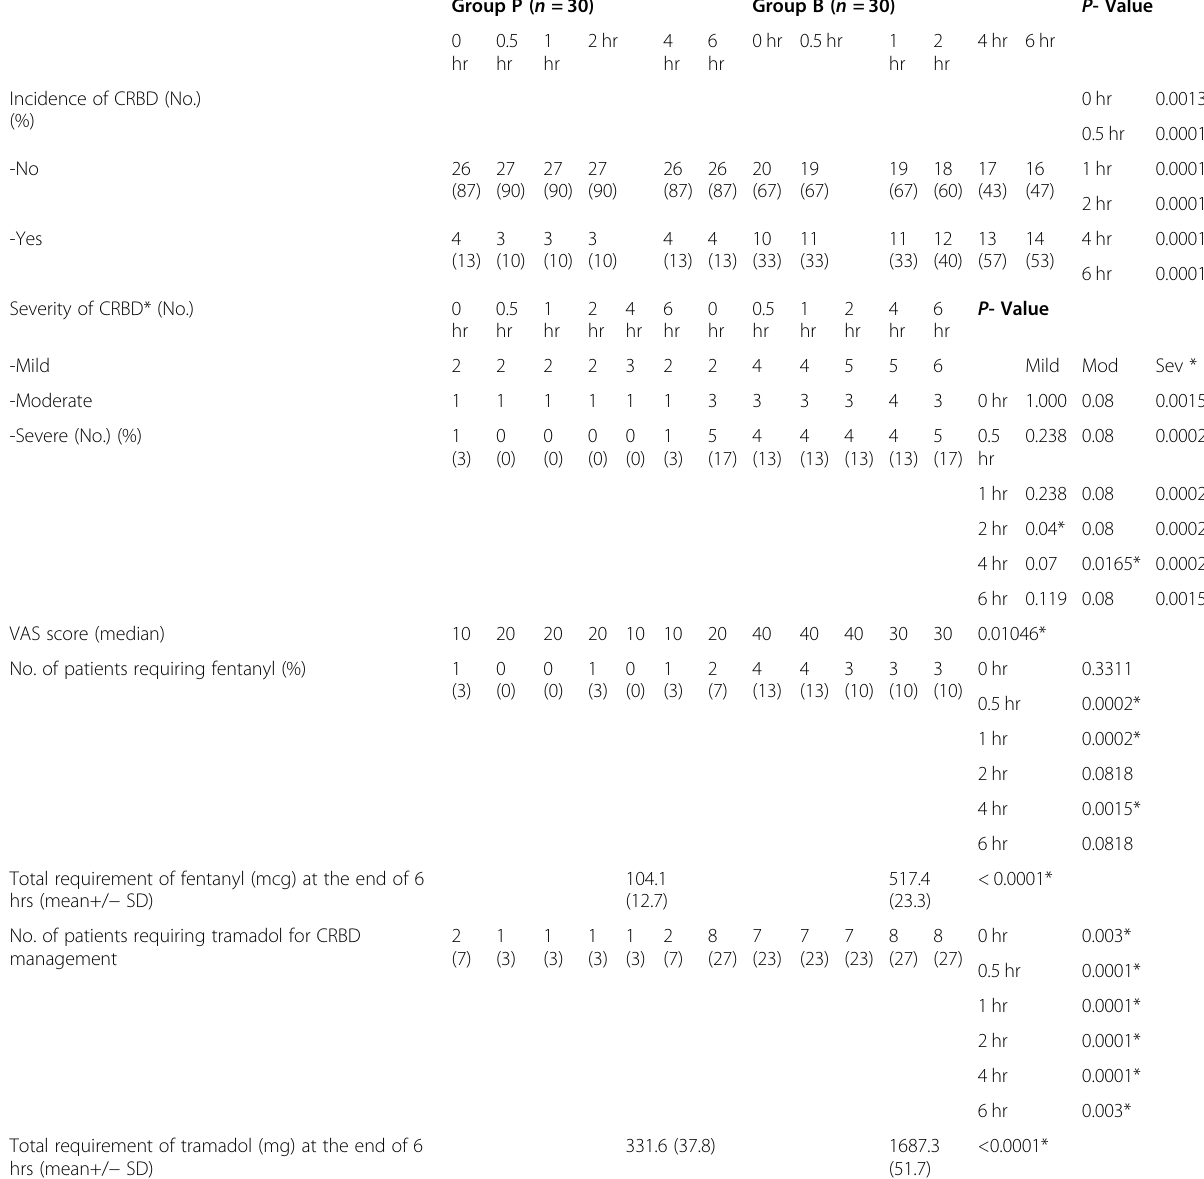
Table 2 Incidence and severity of CRBD,